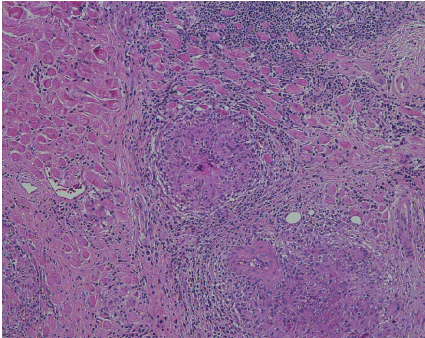
Figure 1: Coronal computerised tomography scan showing di ff use swelling of the left inferior oblique muscle.